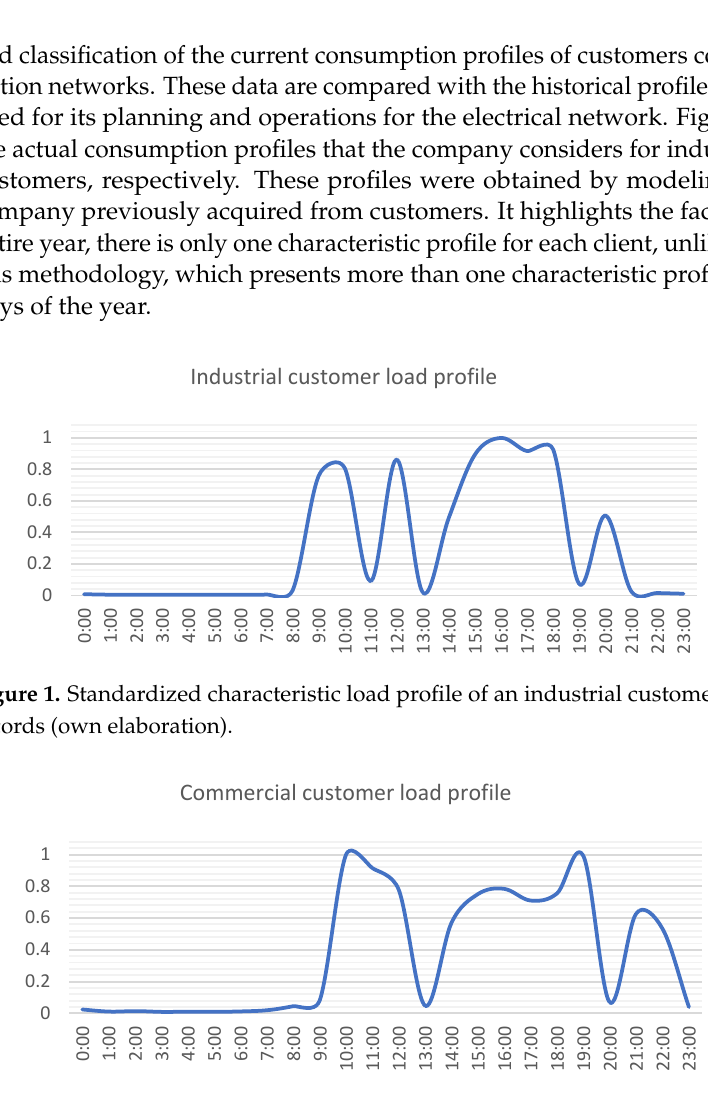
Figure 2. Standardized characteristic load profile of a commercial customer, according to company records (own elaboration).